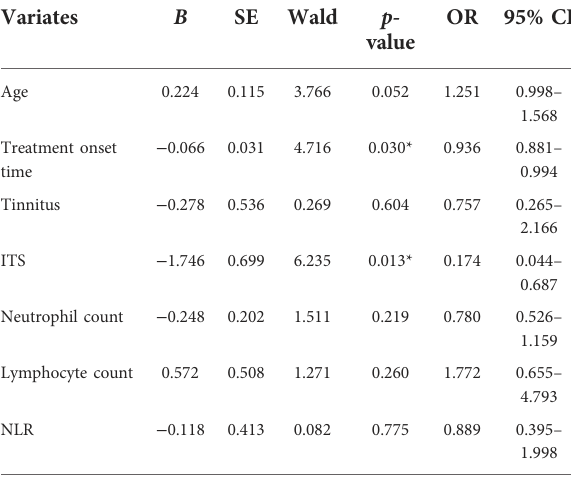
TABLE 5 Logistic multivariate regression analysis of the treatment ef fi cacy in children with profound sudden sensorineural hearing loss.